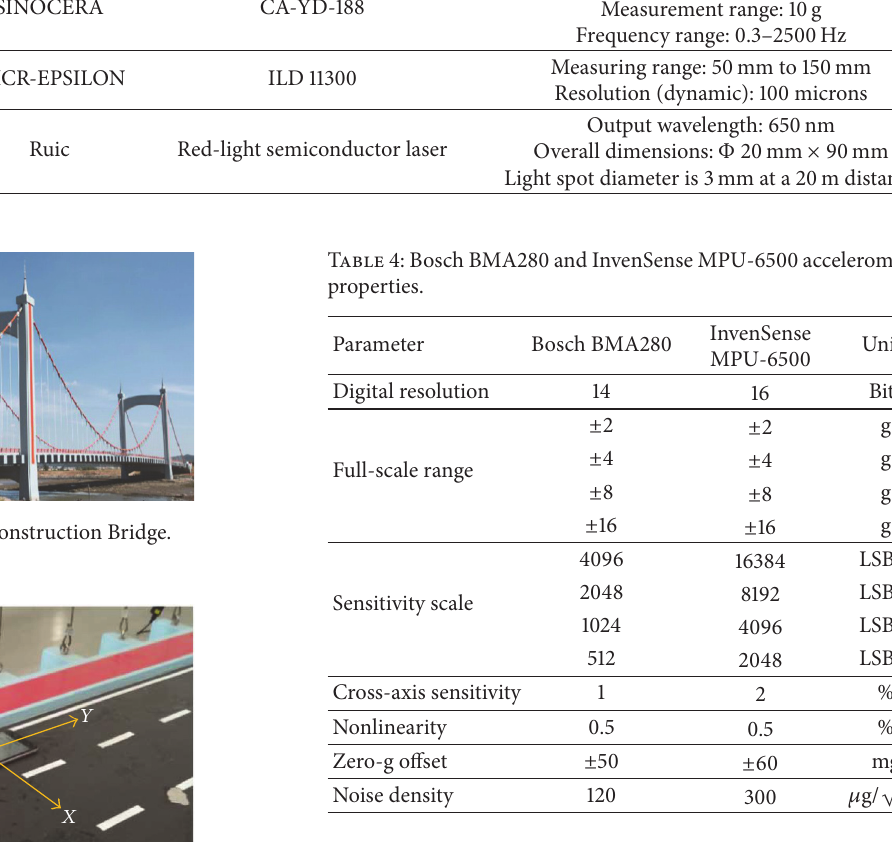
Table 5: InvenSense MPU-6500 gyroscope properties.